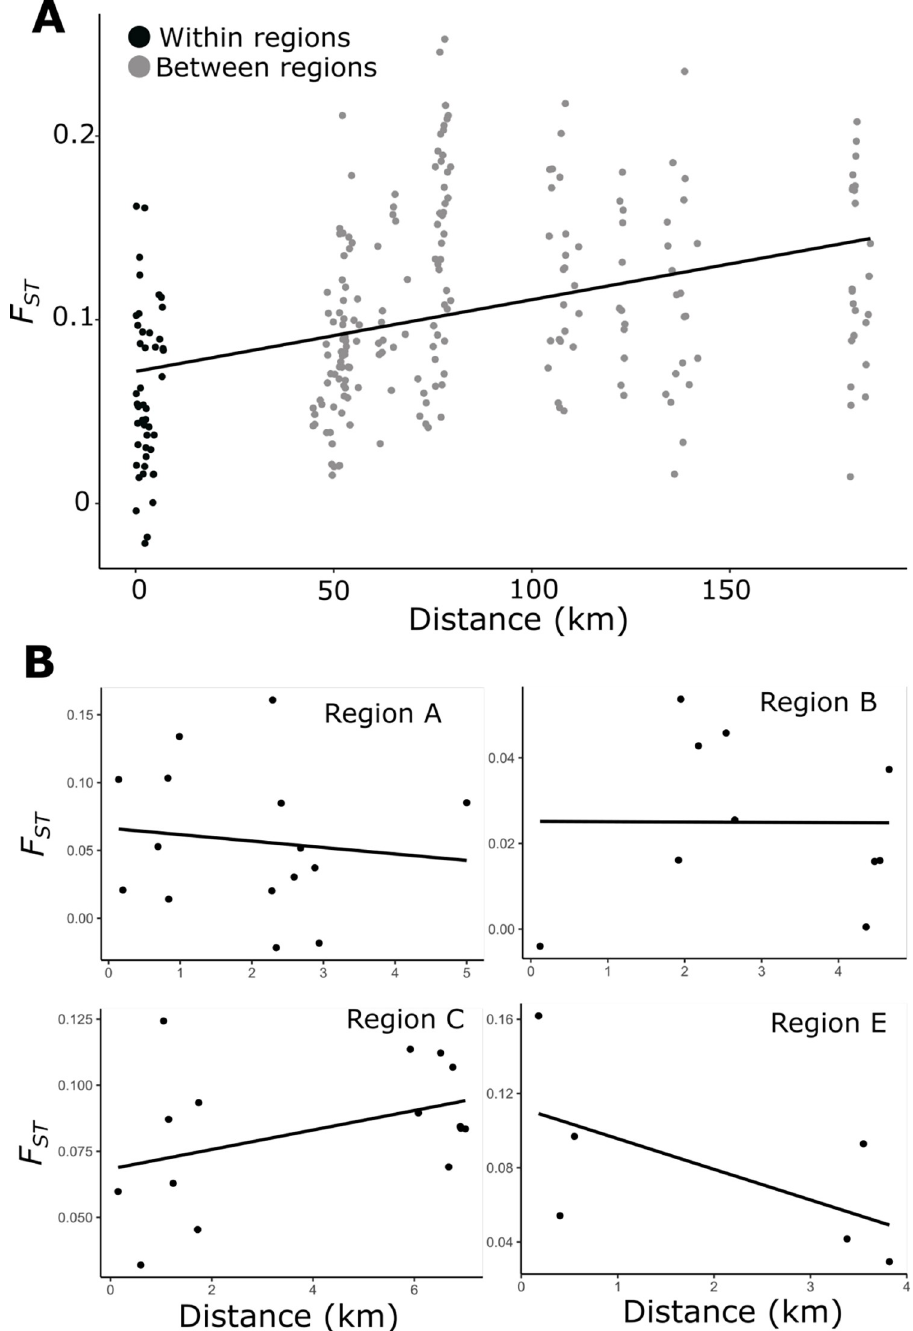
Fig 4. Isolation by distance plots. Segregation of allele frequencies (measured by F versus geographic distance. A. All site pairs in this study, with comparisons within regions shown in black and comparisons between regions in grey. B. Within-region site comparisons, grouped by region (region D is omitted since only two sites were sampled).